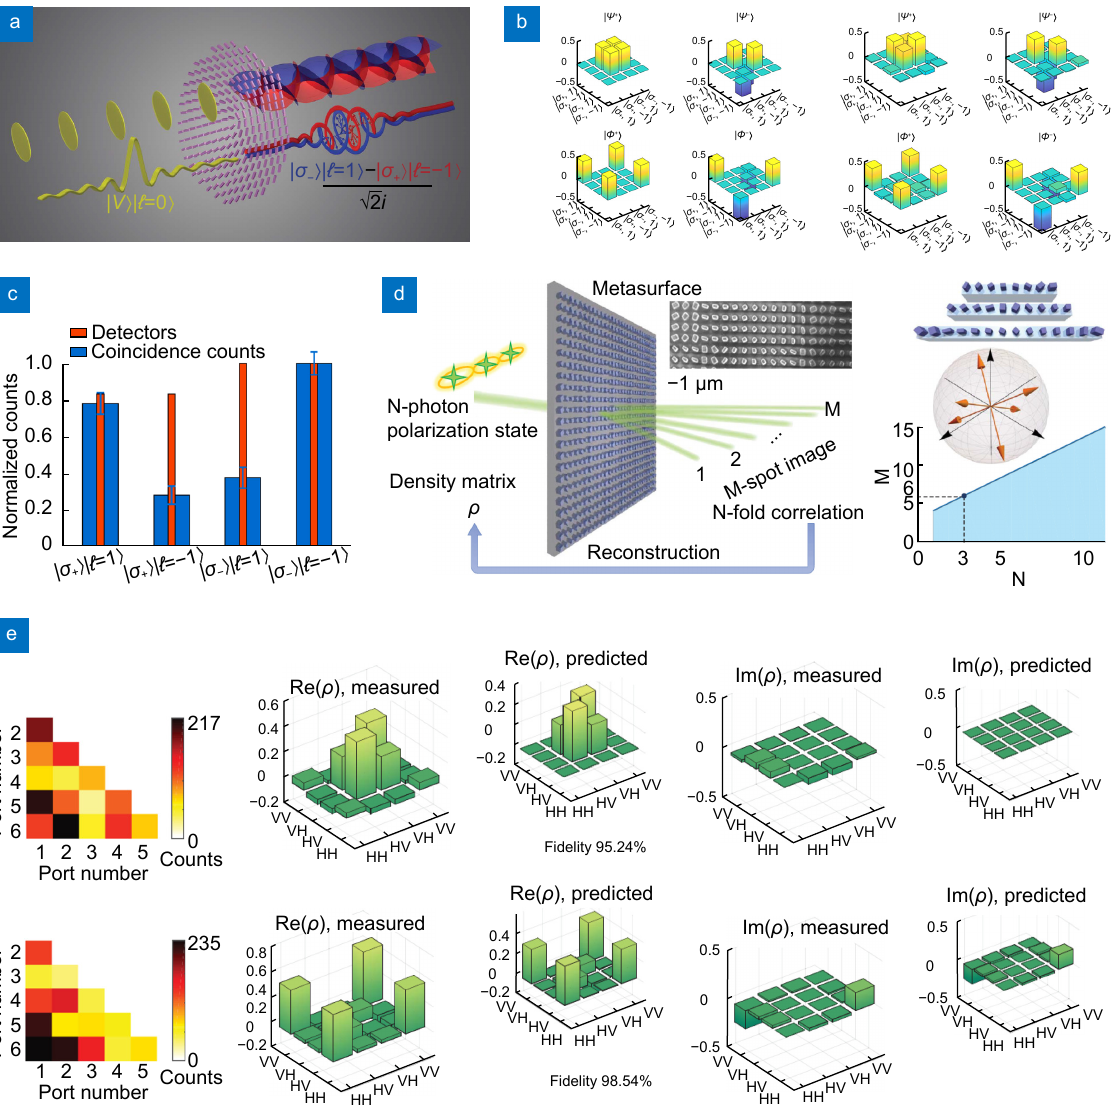
Fig. 2 | Manipulation of quantum states based on metasurface . ( a ) Employing geometric phase associated with metasurface to make photons with different spin polarization state acquire different orbital angular momentum. ( b ) Four bell states of single photon with entanglement of spin angular momentum and orbital angular momentum. ( c ) The mutual entanglement between a photon pair. ( d ) Left is the schematic of quantum state tomography based on metasurface, top right is three different inter-leaved metasurface, middle-right is the graphical representation of 6 dif- ferent polarization states, bottom right is relationship between the minimum number of channels required and the number of photons. ( e ) The re- construction of density matrix of two different photon pair state with fidelities 95.24%, 98.54% respectively. Figure reproduced from: (a-c) ref. 89 ,The American Association for the Advancement of Science; (d-e) ref. 90 , The American Association for the Advancement of